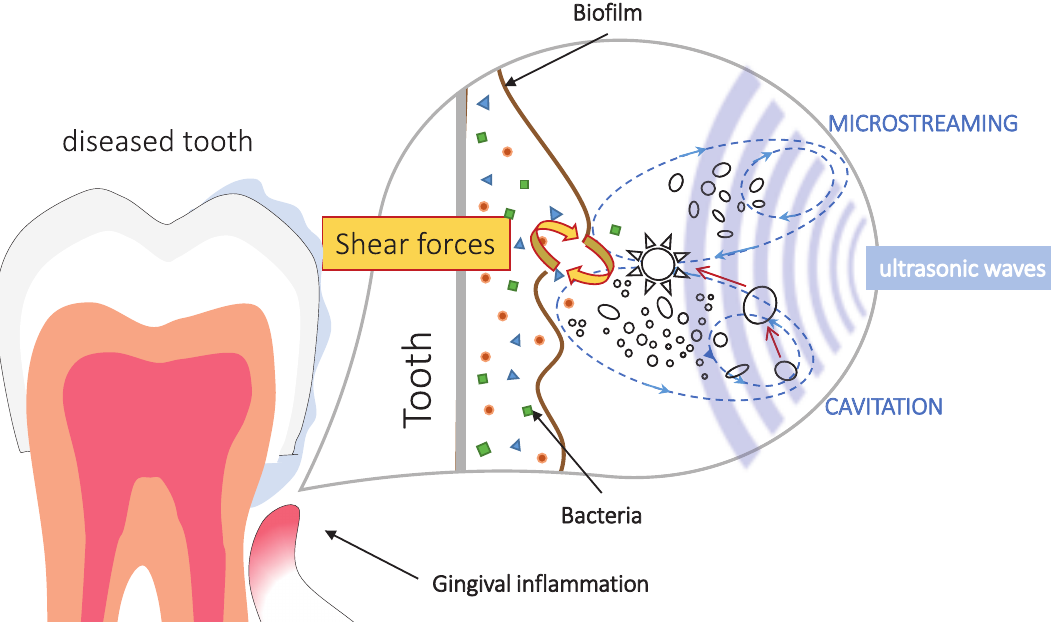
Figure 2. Factors influencing dental biofilm